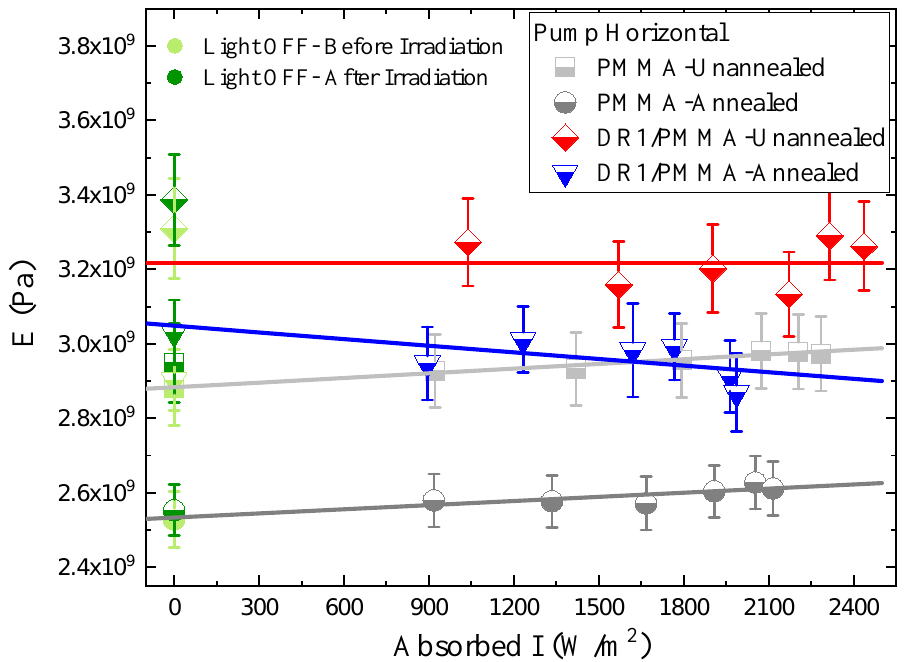
Figure 11. Young’s Modulus of unannealed and annealed PMMA and DR1/PMMA fibers as a function of horizontally polarized absorbed pump intensity. The lines are fits to the non-zero-intensity data